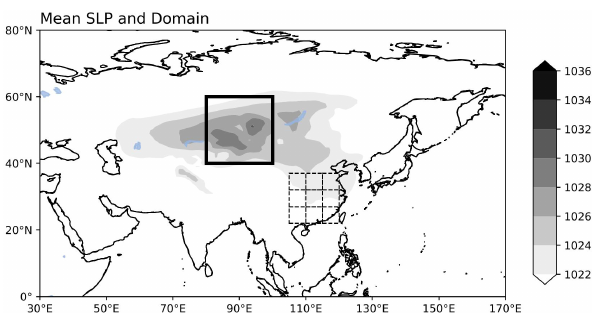
Figure 1. The domain of the Siberian high (thick solid box; 40– 60 ◦ N, 80–100 ◦ E) and EC (dotted box; 22–37 ◦ N, 106–121 ◦ E) di- vided into 5 ◦ × 5 ◦ grid boxes. Shading indicates the cool-season mean